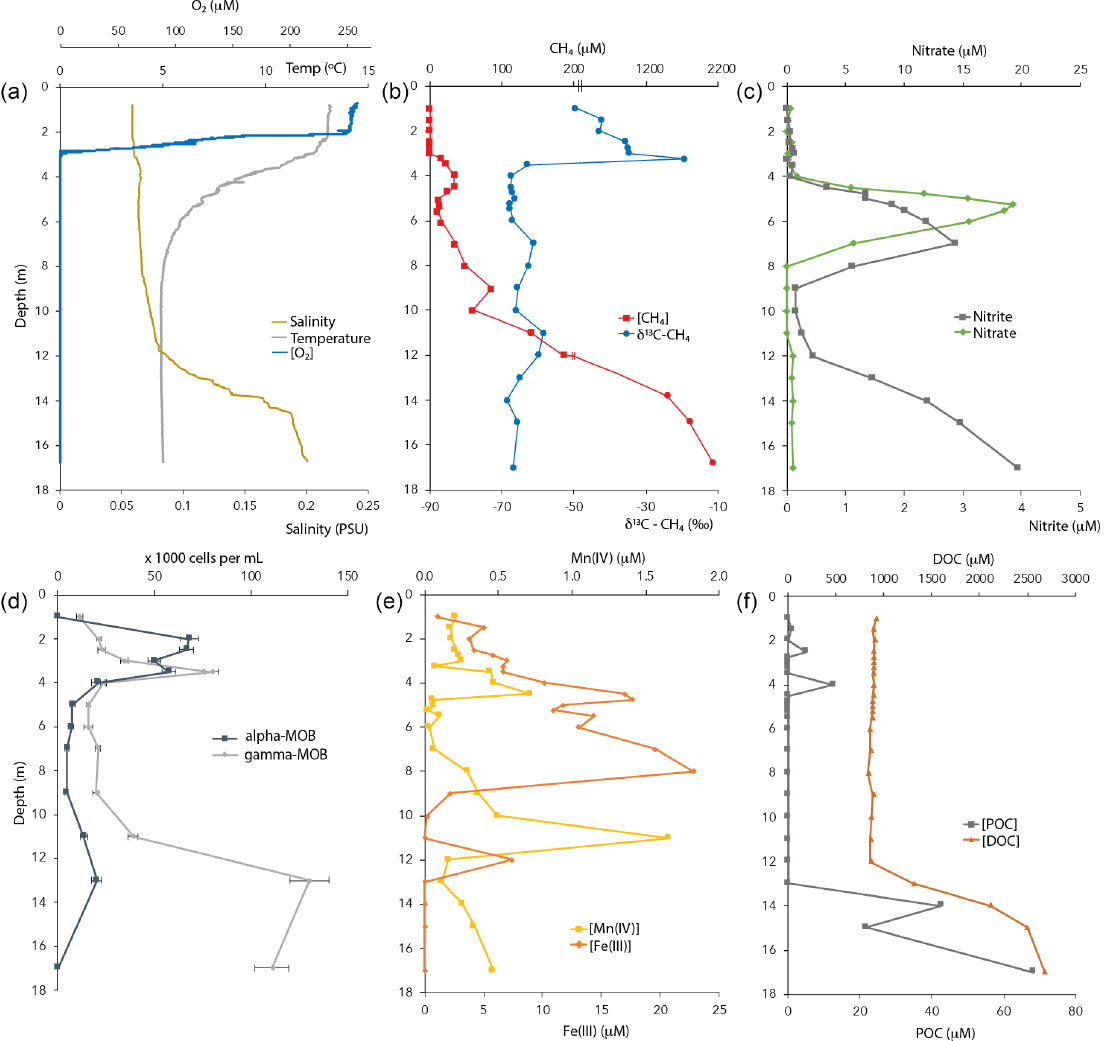
Figure 1. Physicochemical characteristics and CH 4 -oxidizing bacterial (MOB) abundance in the Lake Lovojärvi water column in September 2015. POC – particulate organic carbon. DOC – dissolved organic carbon. Note the break at the [CH 4 ] axis in (b) . The oxygen profile combines data obtained by two different oxygen sensors, for low and high concentrations (see